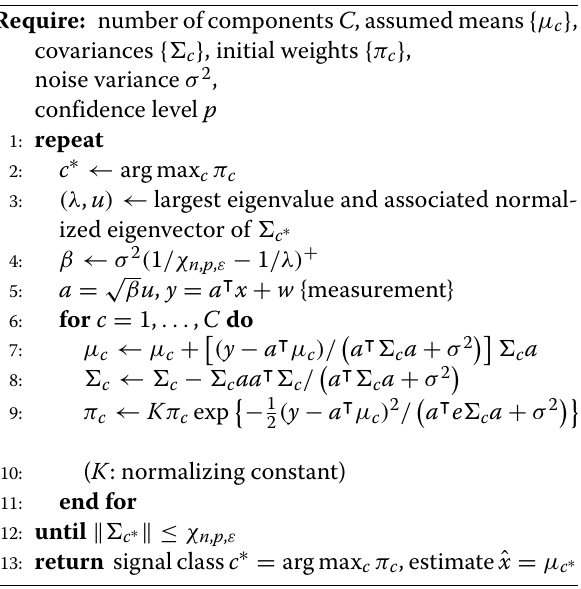
Algorithm 3 Heuristic Info-Greedy Sensing for